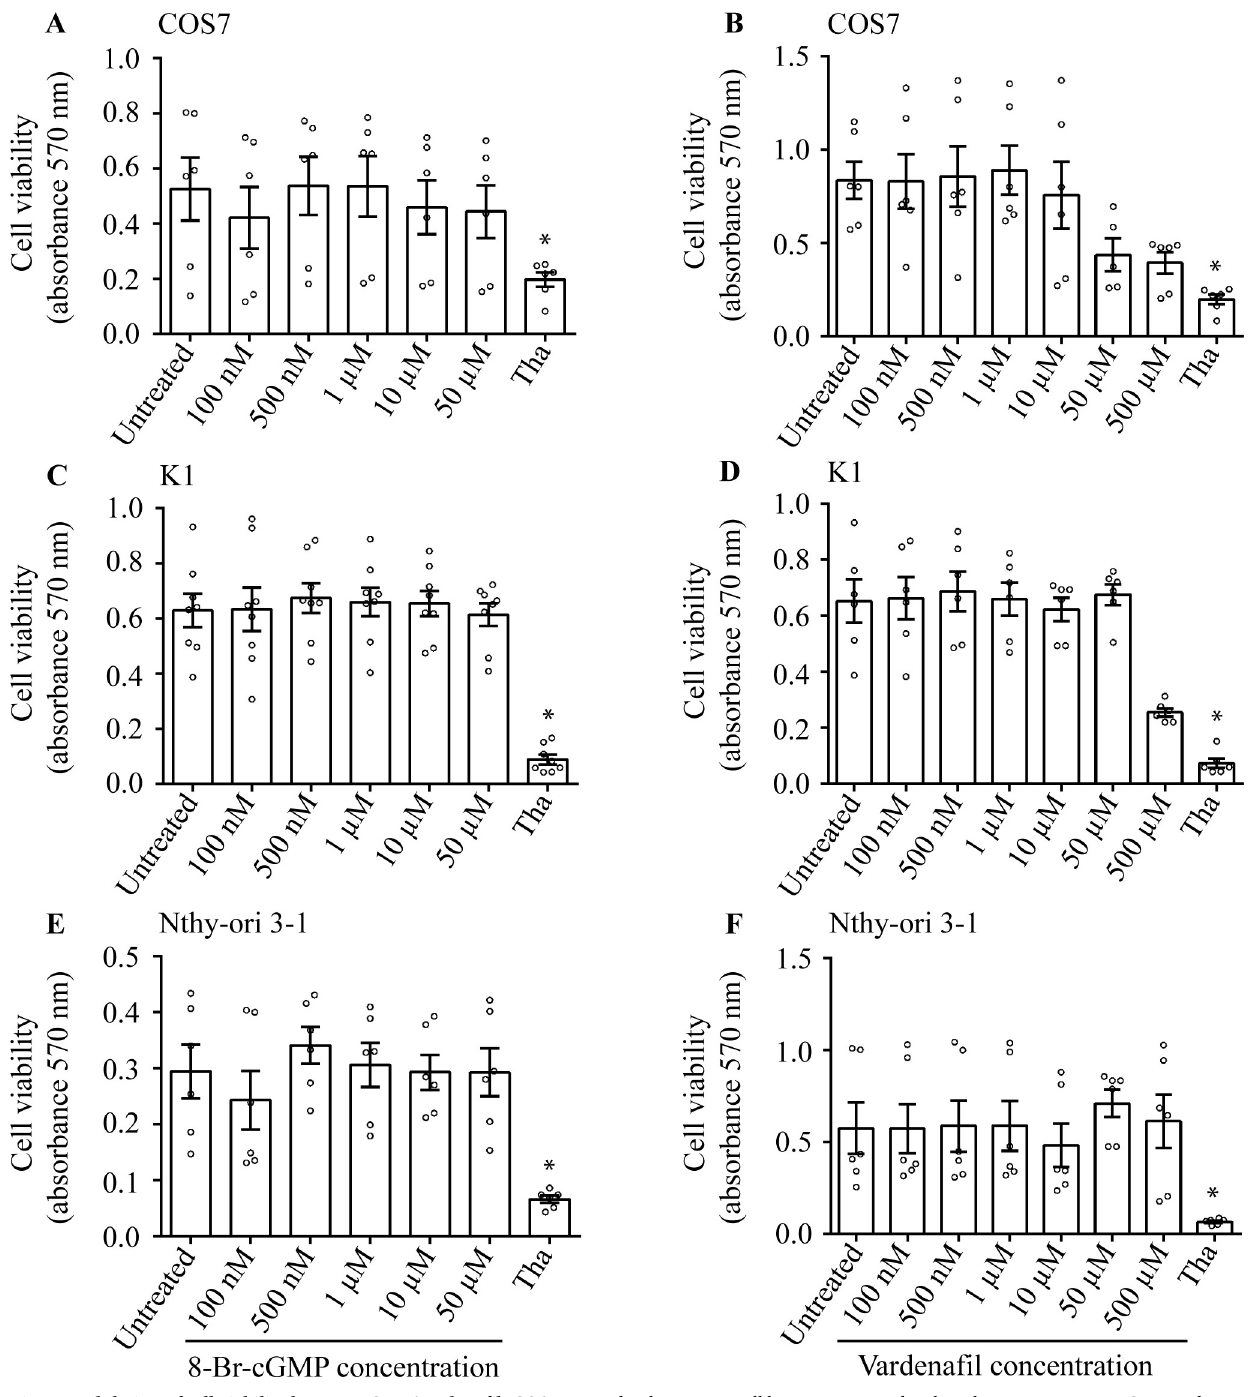
Fig 2. Modulation of cell viability by 8-Br-cGMP/vardenafil. COS7, K1 and Nthy-ori 3–1 cell lines were treated 24 h with increasing 8-Br-cGMP and vardenafil (100 nM– 500 μ M range). Cell viability was evaluated by MTT assay and indicated as an absorbance detected at the 570 nm wavelength. 4 μ M thapsigargin served as a positive control (Tha) for cell viability decrease and results were compared by Kruskal Wallis test and Dunn’s post-test ( � significantly different versus untreated sample; p < 0.05; means ± SEM; n = 6 to 8). A, B) Data from the COS7 cell line treated with 8-Br-cGMP and vardenafil, respectively; C, D) Results from treatments of K1 cells; E, F) Nthy-ori 3–1 cell line.